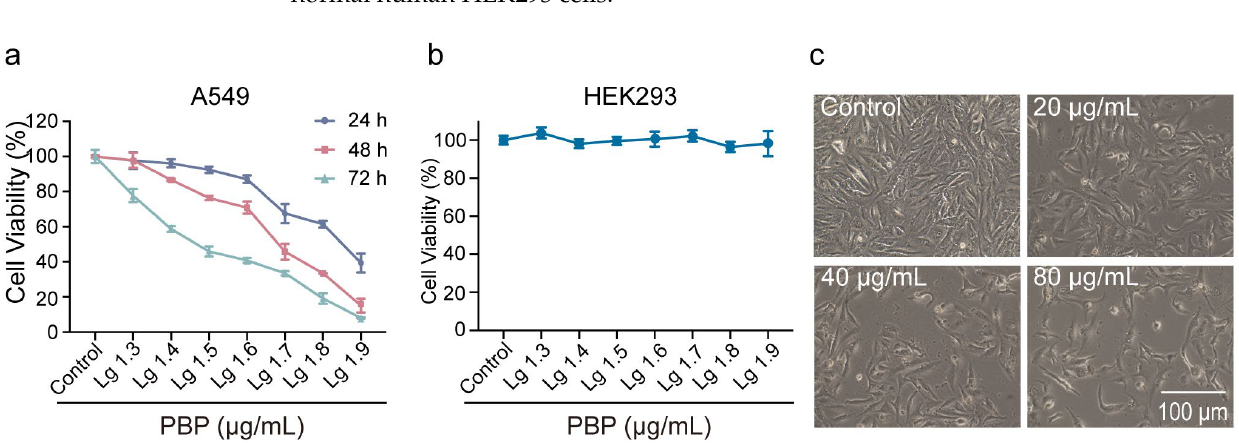
Figure 5. Cytotoxicity of PBP to A549 cells. ( a ) A549 cells viability was assayed using the CCK-8 assay, after being exposed to varying amounts of PBP for 24, 48, and 72 h; ( b ) Cytotoxicity of PBP to HEK293 cell in 48 h determined by CCK-8 assays; ( c ) Typical morphological changes in A549 cells after treatment with PBP for 48 h. Table 3. Inhibitory effects of PBP on viability of various tumor cells. Tumor Cell